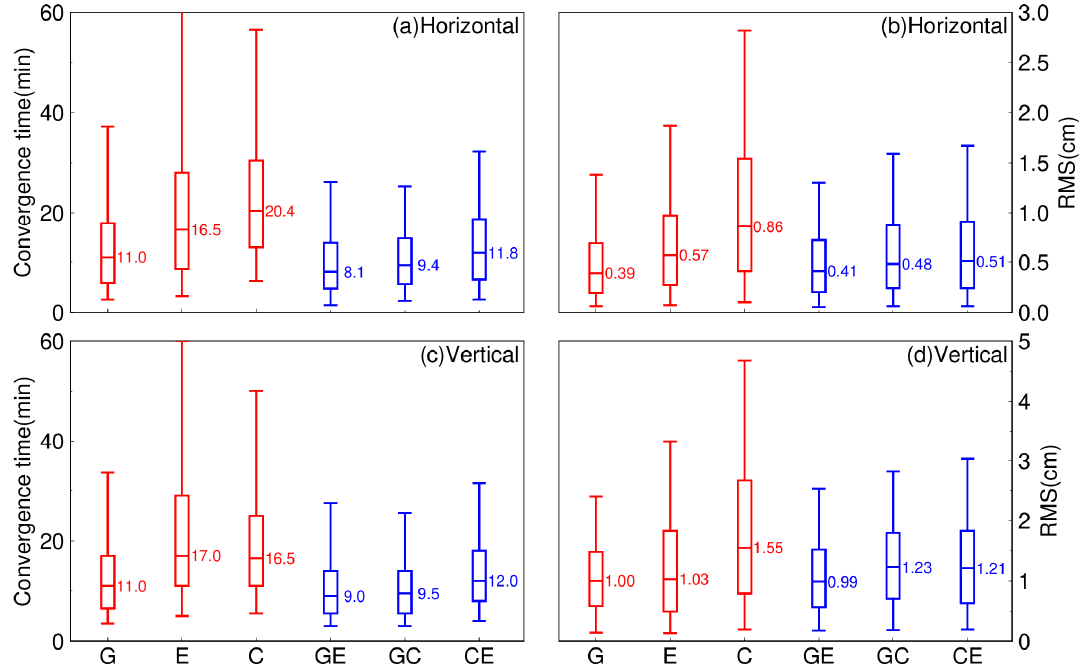
Figure 11. Distribution of the convergence time and RMS of static PPP solutions for the single sys- tems (G is short for GPS, E is short for Galileo, and C is short for BDS-3) and dual-system combinations (GE is short for GPS combined with Galileo, GC is short for GPS combined with BDS-3, and CE is short for BDS-3 combined with Galileo) in September 2022. ( a ) Horizontal component of convergence time, ( b ) Horizontal component of RMS, ( c ) Vertical component of convergence time, ( d ) Vertical component of RMS.